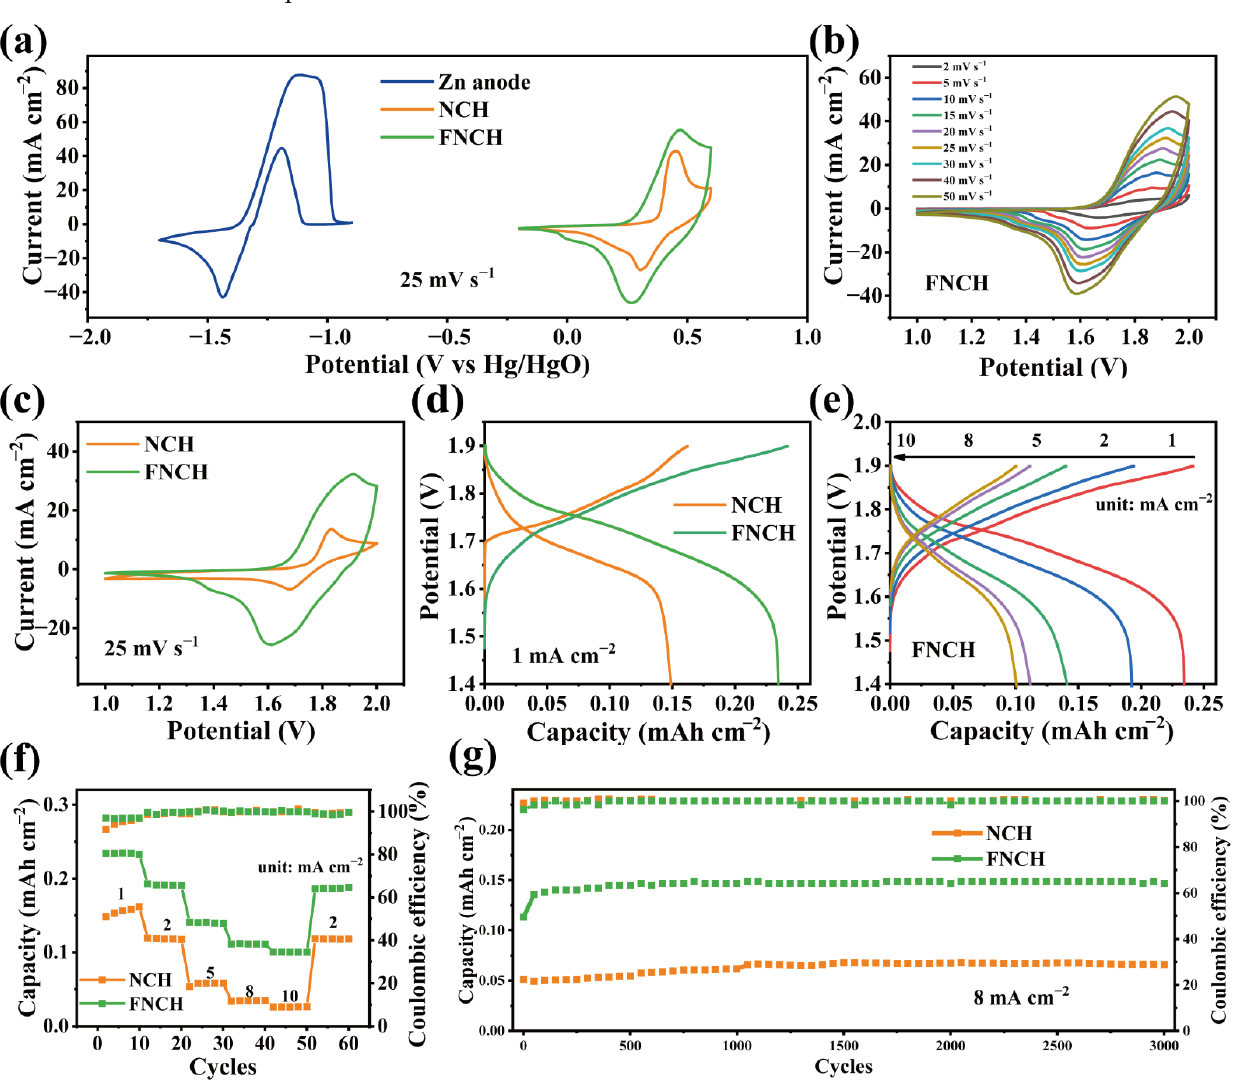
Figure 6. Electrochemical performance tests of FNCH – Zn and NCH – Zn batteries. ( a ) CV curves of Zn anode, FNCH and NCH cathode material at 25 mV s −1 . ( b ) CV curves of FNCH – Zn battery. ( c ) CV curve comparison of FNCH – Zn and NCH – Zn battery. ( d ) GCD curves of FNCH – Zn battery. Comparison of GCD curve ( e ), rate capacity ( f ) and cycling performance ( g ) for FNCH – Zn and NCH – Zn battery.